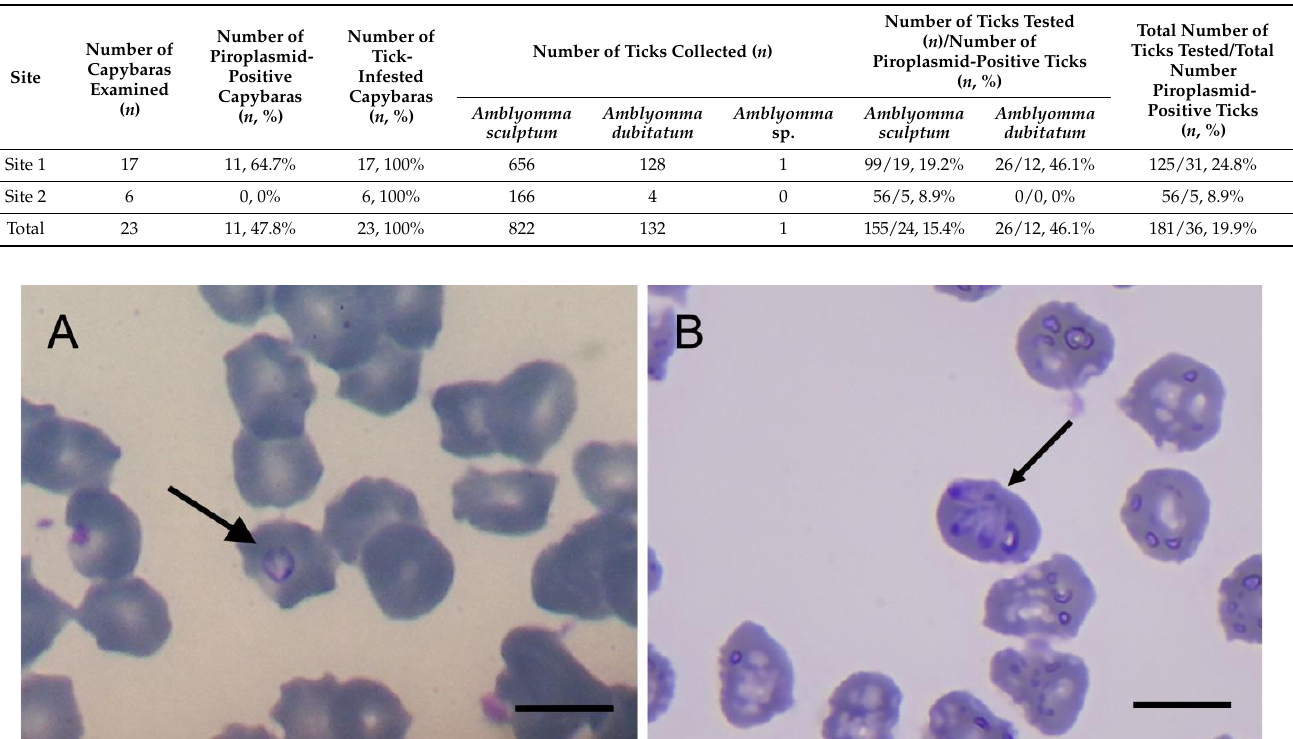
Table 1. Number of tick-infested and piroplasmid-positive capybaras according to each collection site. The number and species of ticks identified, as well as the number of positive ticks, is also shown.